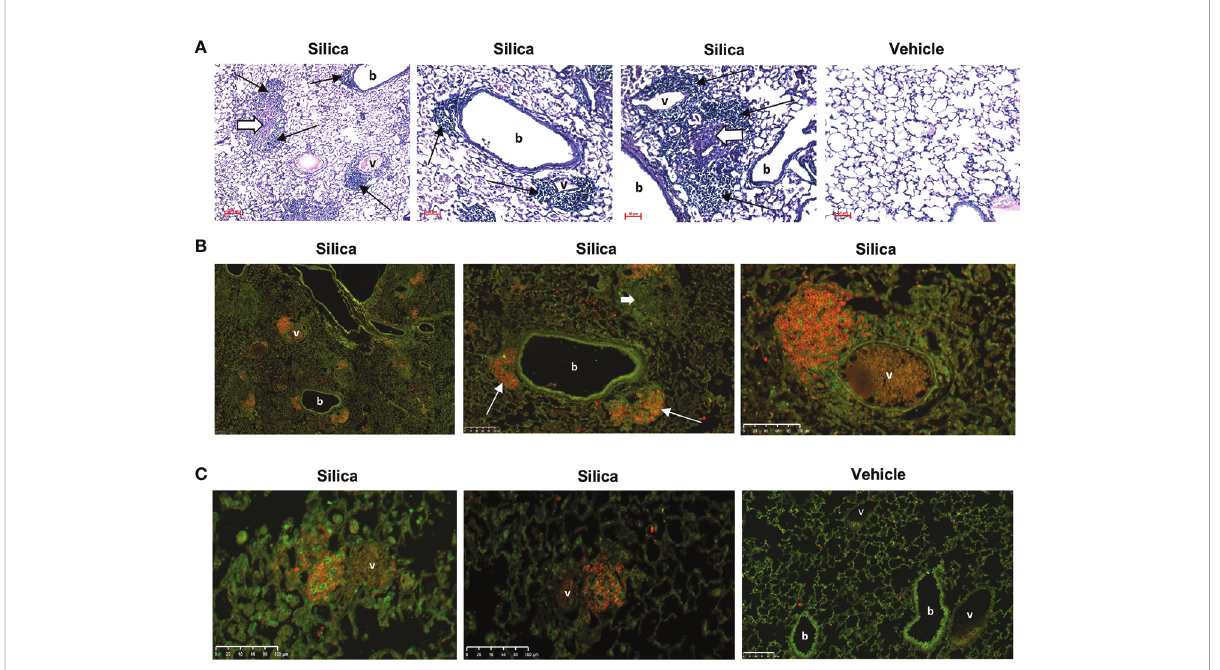
FIGURE 1 Lung in fl ammation and lymphocyte in fi ltration in female BXSB mice exposed to respiratory crystalline silica or vehicle and i.p. lipopolysaccharide (LPS). (A) Representative sections of lungs from mice exposed by oropharyngeal aspiration (OPA) at 3 months, and to Toll-like receptor-4 ligand LPS by i.p. injection at 2 days, prior to organ harvest. PAS, magni fi cation indicated by micron bar. Thin black arrows indicate ectopic lymphoid aggregates; short thick white arrows indicate chronic in fl ammation. (B, C) Immuno fl uorescence staining of ectopic lymphoid structures in lung sections from three different mice exposed to silica, and one mouse exposed to vehicle (saline), by OPA and to LPS i.p. injection. Lung sections were stained with anti-B220 (B cells, red) and anti-CD3e (T cells, green); b = bronchiole; v = blood vessel. (B) Images are derived from the same silica-exposed mouse; the two right images show details within the lower power image on the left. Two lymphoid structures each encompassing a small blood vessel and adjacent to a bronchiole are indicated by thin white arrows. Diffuse lung injury and in fl ammation are also evident in the lung sections; the short thick white arrow indicates a